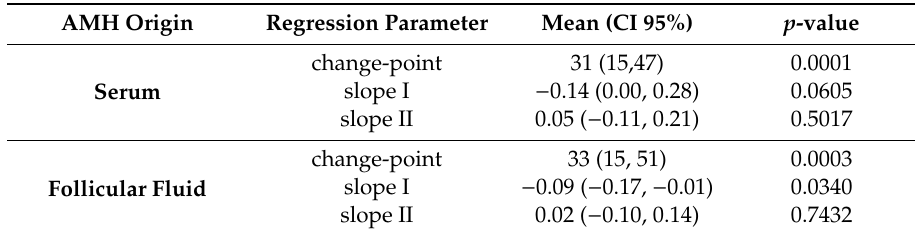
Table 4. Segmented regression of AMH concentrations in relation to vitamin D concentration.